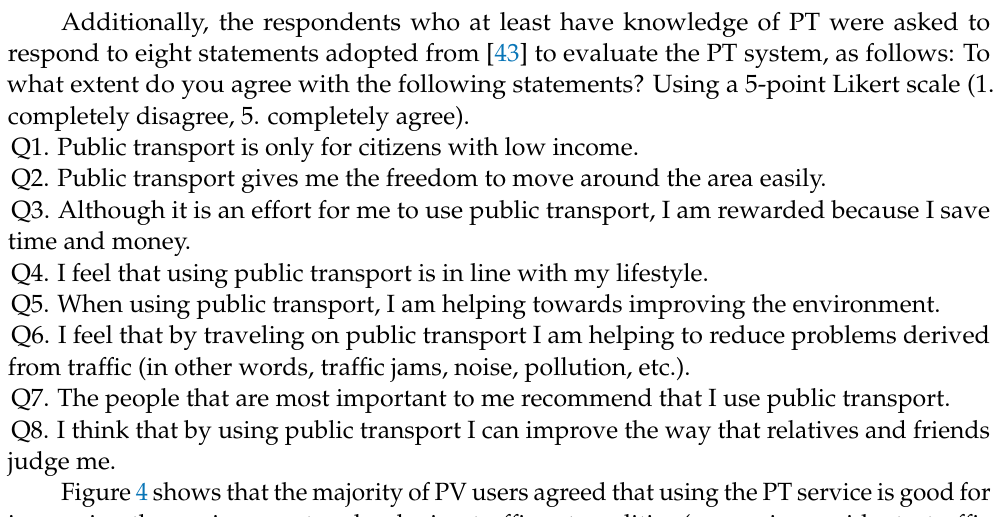
Figure 3. The overall satisfaction of PV users with car service ( a ) and with PT service ( b ) on 1–5 Likert scale.